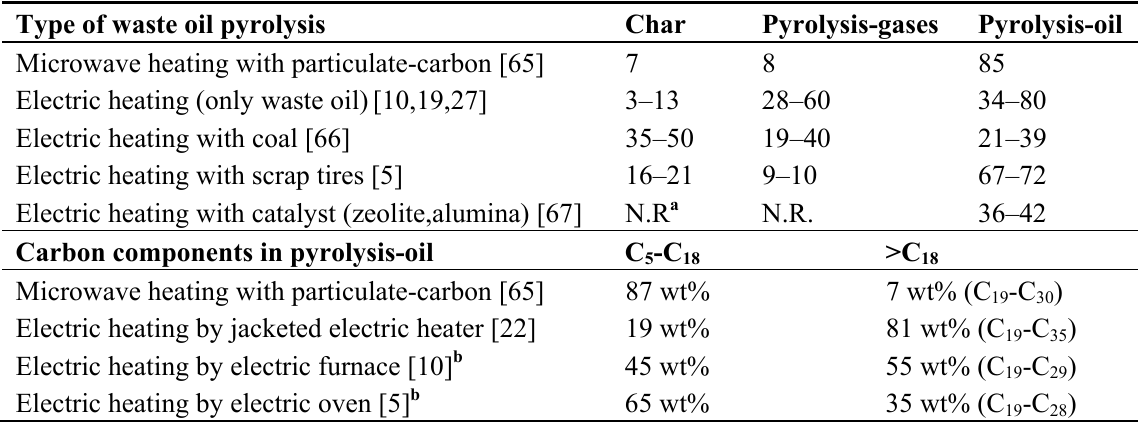
Table 1. Comparison of product yield (wt%) in waste oil pyrolysis processes heated with different media, and driven by microwave heating and conventional electric heating (wt%—weight